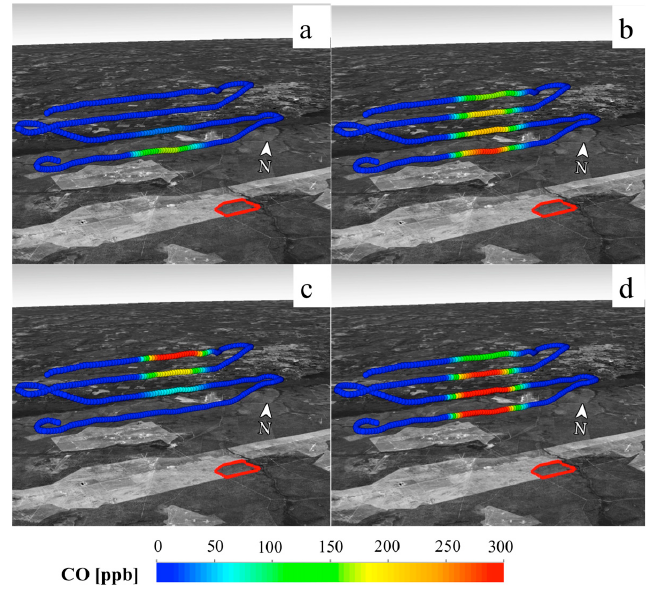
Figure 11. CO enhancements during the parking garage #3 transect at 2035 UTC for ( a ) no plume rise, ( b ) PBL dilution, ( c ) plume-top, and ( d ) Gaussian plume model configurations. The red polygon in the lower right corner of each panel indicates the L2F burn plot. Map data: Google, DigitalGlobe.